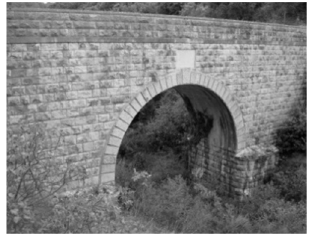
Figure 12. Franjo Josip, Bra č (B9).